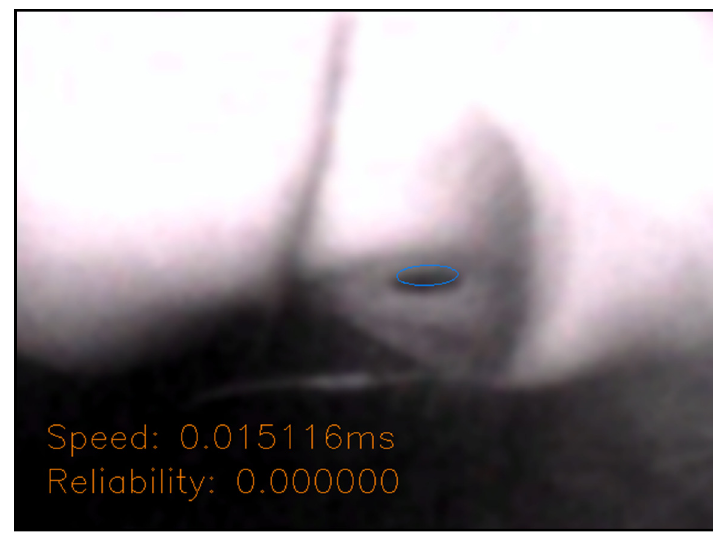
Figure 54. Dark pixels of the pupil are too less or unstable shape of ellipse.